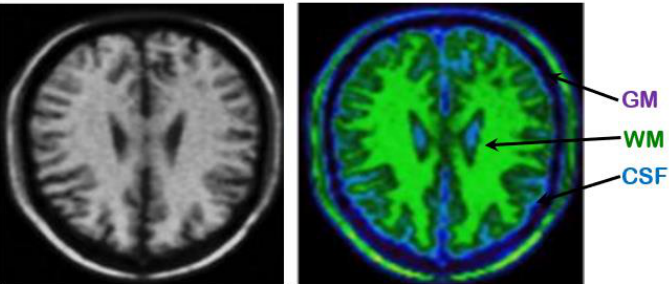
Figure 4. Example of a labeled anatomical image from automatic segmentation based on the hybrid GA / BCFCM / PFCM clustering approach with additive noise level is 20%, slice thickness is 5 and inhomogeneity of the radio frequency is 20%.